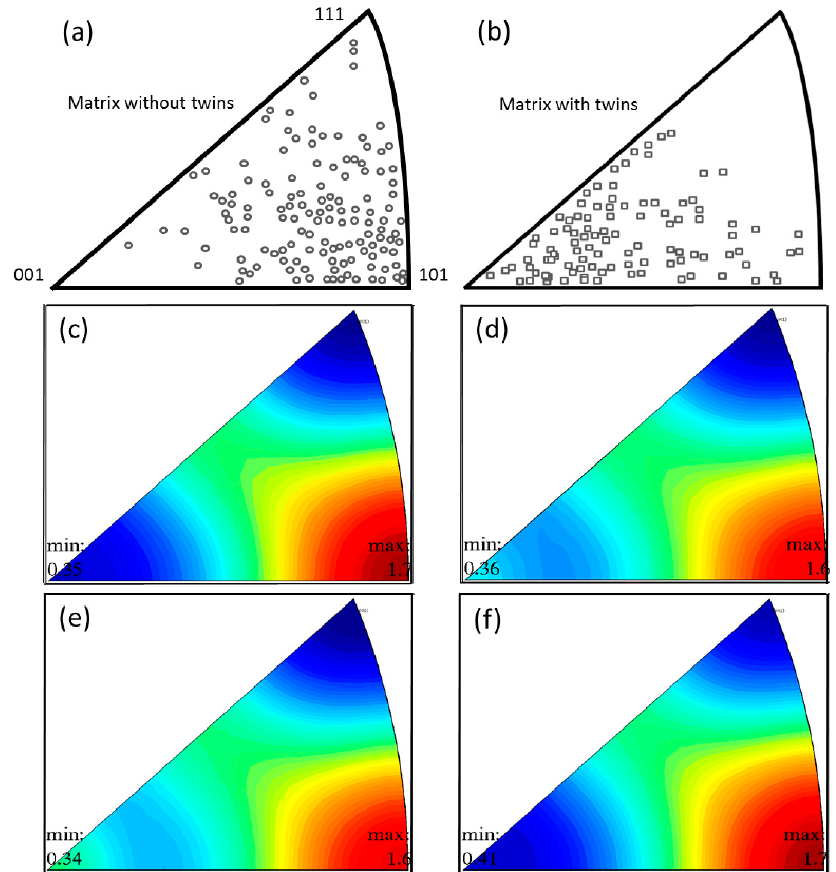
Figure 7. Inverse pole figure of compression direction for ~20% compressed specimens. ( a ) orientation of the grains without twinning; ( b ) orientation of the grains producing deformation twins (reproduced from Reference [18]); and ( c – f ) texture distribution of specimens that experienced ~20% compressive strain with a strain rate of 1581 / s, 100 / s, 10 / s and 0.01 / s, respectively.